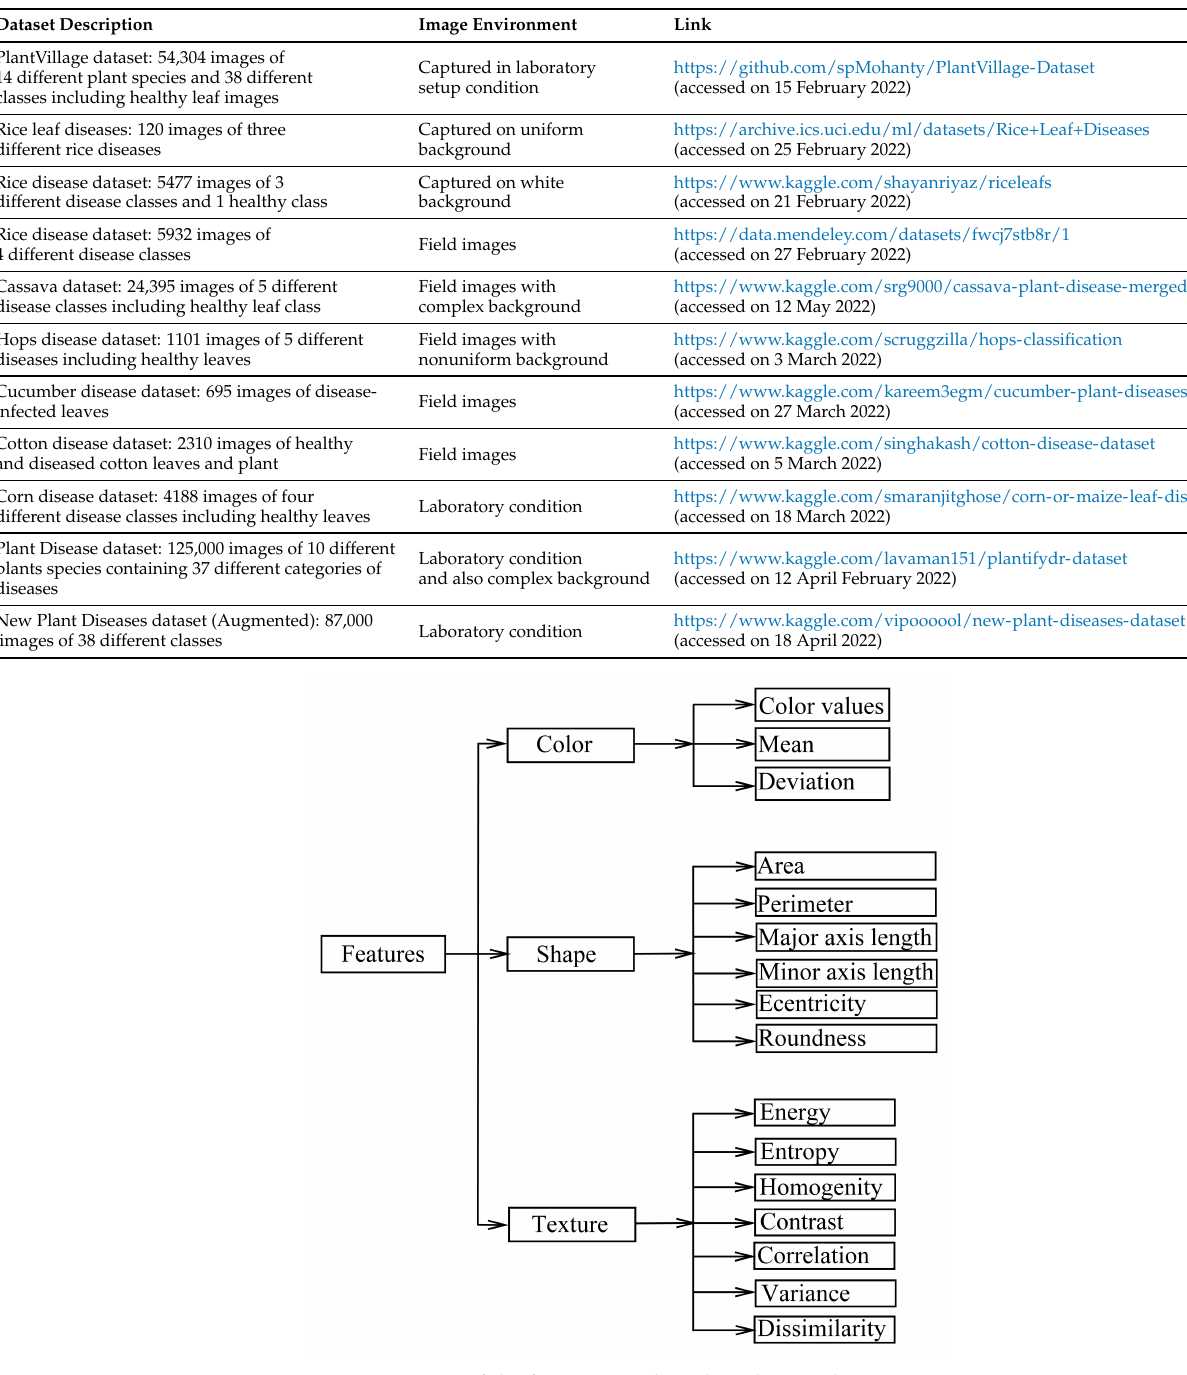
Figure 1. Some of the features used in plant disease